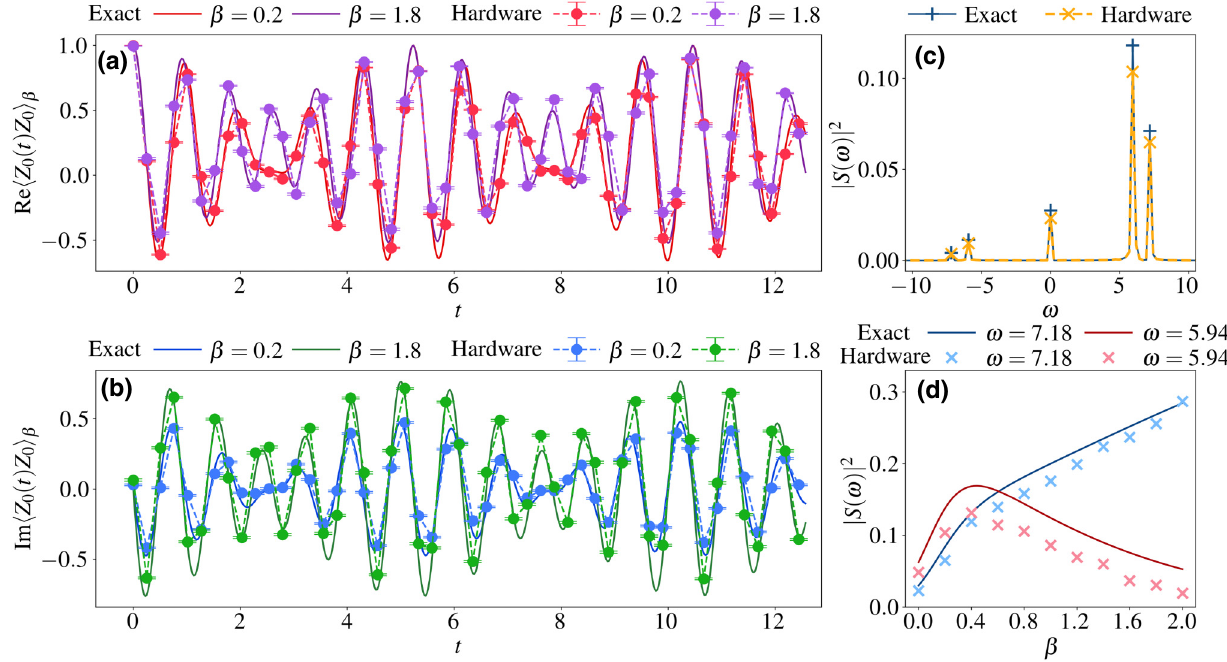
FIG. 7. Finite-temperature dynamical properties of the two-site TFIM with J = 3, h = 1. The imaginary-time-step size in QITE is set to (cid:3)τ = 0.1. (a) Real and (b) imaginary parts of the finite-temperature dynamical correlation function (cid:9) Z 0 ( t ) Z 0 (cid:7) β at β = 0.2 and β = 1.8 versus real time t . (c) Finite-temperature excitation spectra | S (ω) | 2 versus frequency ω . Positive (negative) frequencies correspond to emissions (absorptions). (d) Amplitudes of the two emission peaks at ω = 7.18 and ω = 5.94. The hardware data capture finite-temperature dynamics of two-site TFIM across a wide range of